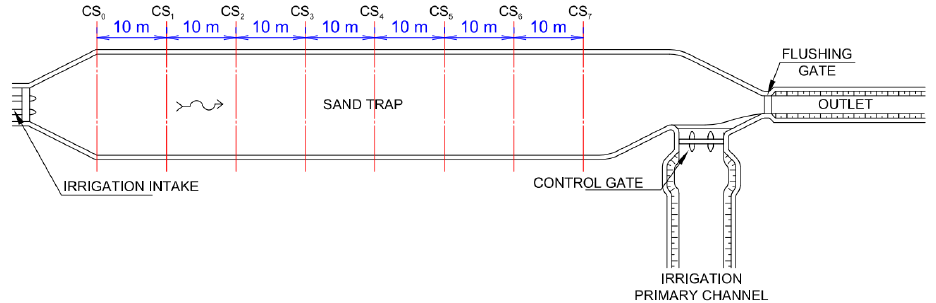
Figure 7. The layout for measuring the water surface denotes eight measurement cross-sections with